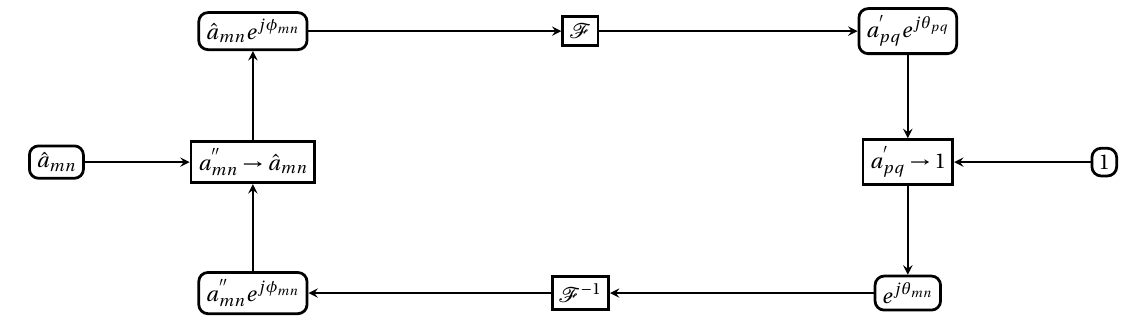
Figure 1. Flow chart for the Gerchberg-Saxton (GS)